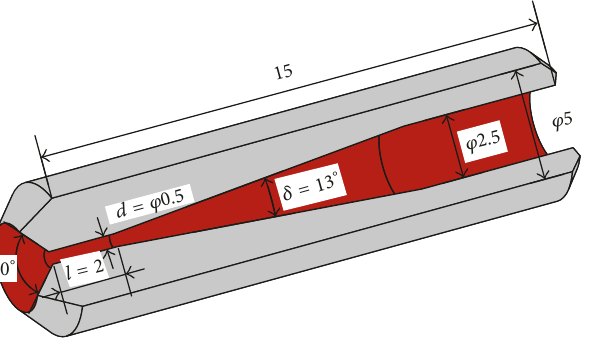
Figure 6: Nozzle installation